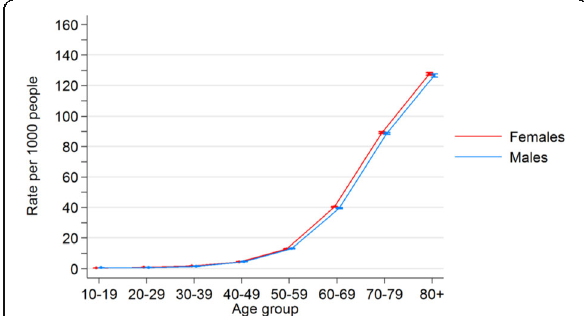
Fig. 2 Rates of anti-Glaucoma medication use in the 2016 Australian resident